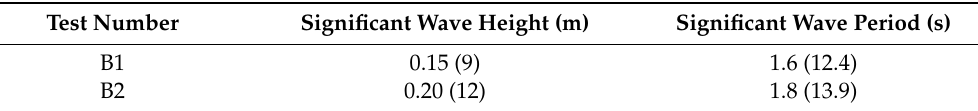
Table 5. Regular waves for the physical model experiment.